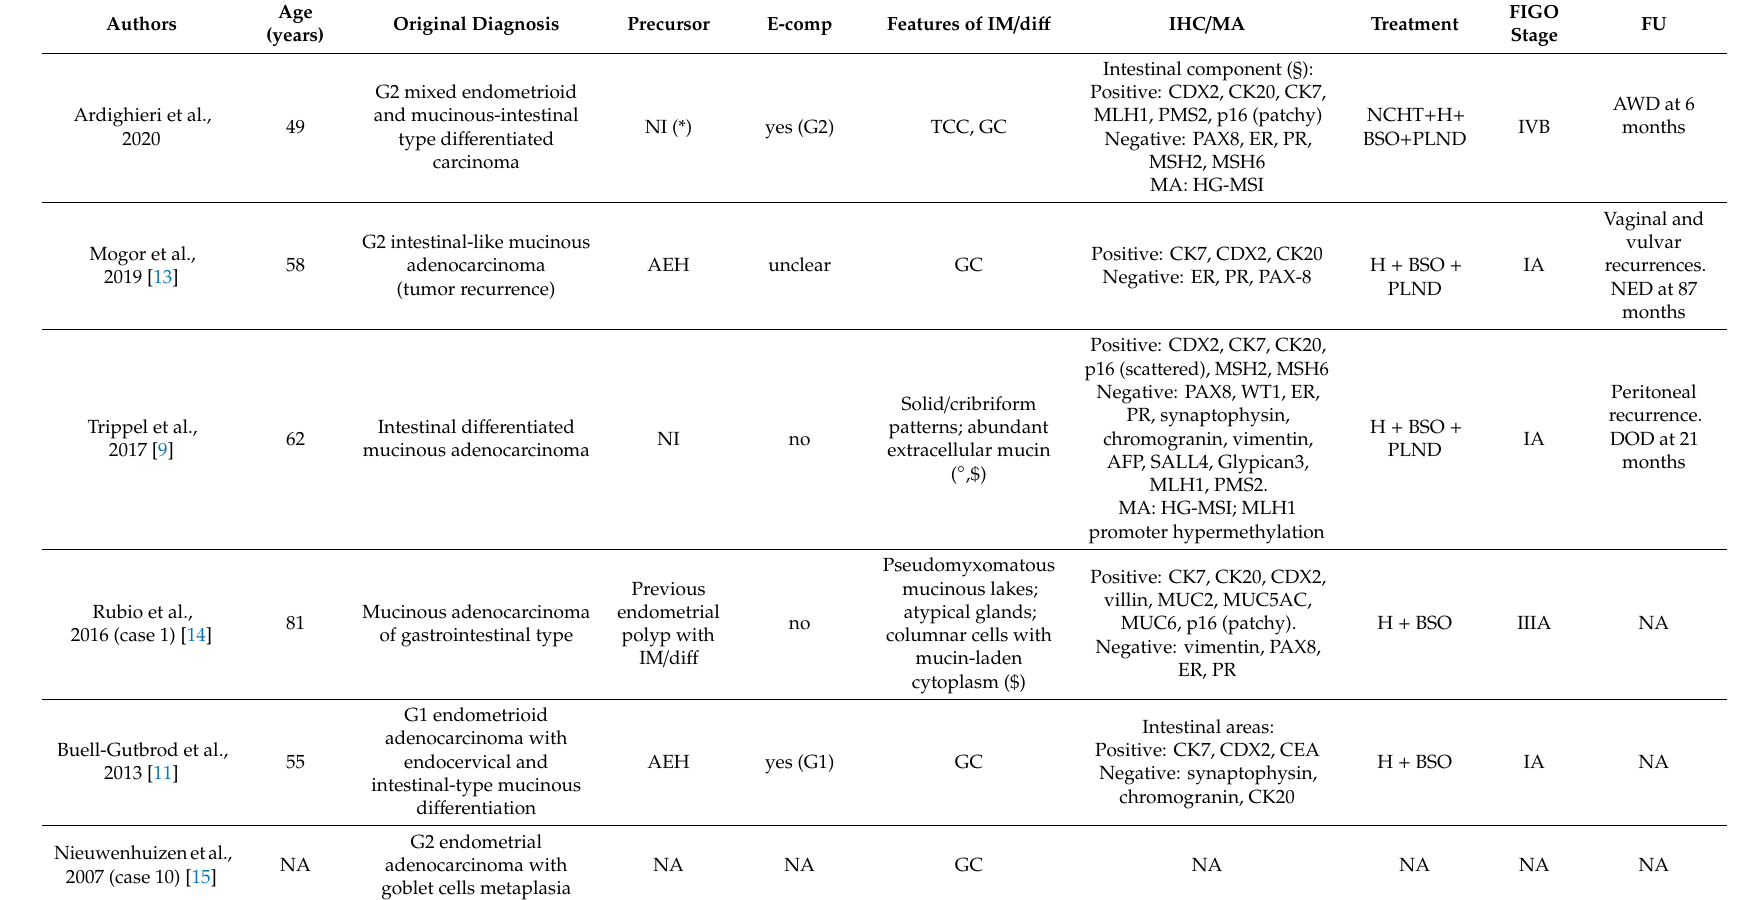
Table 2. Literature review of endometrial carcinomas showing intestinal type metaplasia / di ff